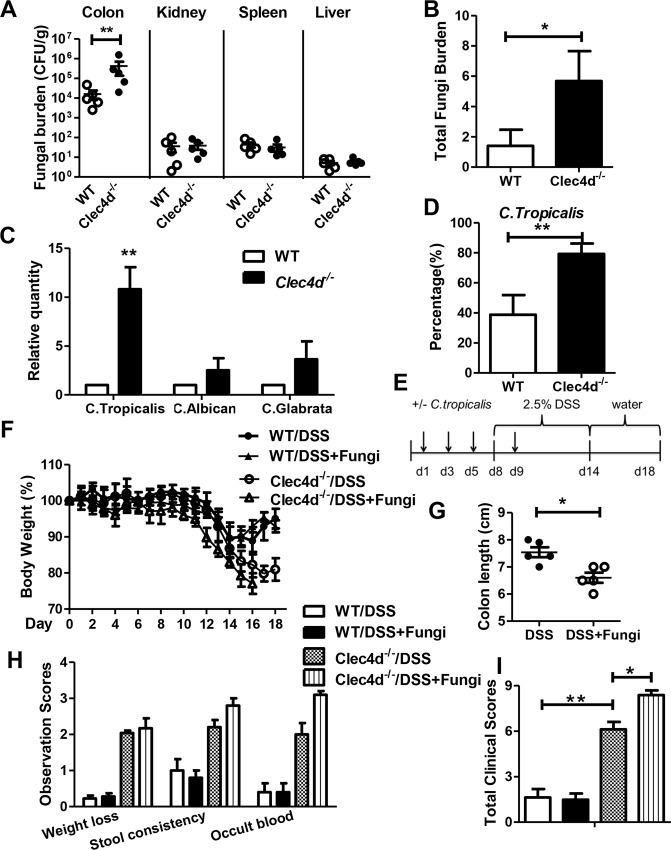

C. tropicalis supplementation aggravates colitis in Dectin-3-deficient mice.(A)WT and Clec4d
-/- mice (n = 5 per group) were treated with as described in Fig 1. Total fungal burdens in the colon, kidney, spleen, and liver were detected using a CFU assay. (B) Quantitative analysis of total fungal burden in the feces of WT and Clec4d
-/- mice using qPCR. (C) Quantitative analysis of C. tropicalis, C.albicans and C.glabrata in the feces of WT and Clec4d
-/- mice at the end of mice model using qPCR. (D) The ratio of C.tropicalis to total fungus was calculated using qPCR. (E) WT and Clec4d
-/- mice (n = 5 per group) underwent supplementation with or without four doses of C. tropicalis and then given 2.5% DSS for 7 days and water for an additional 4 d. (F and G) Severity of colitis were assessed by measuring body weights and colon lengths of each mice. (H-I) Disease severity was assessed using clinical colitis scores. Data represent one of two independent experiments. Error bars, SD. *P < 0.05; **P < 0.01.